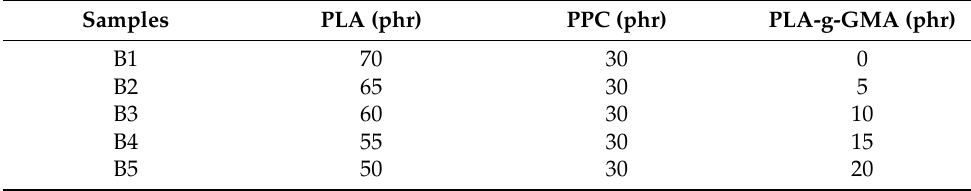
Table 2. The composition of the PLA/PPC/PLA-g-GMA blends.